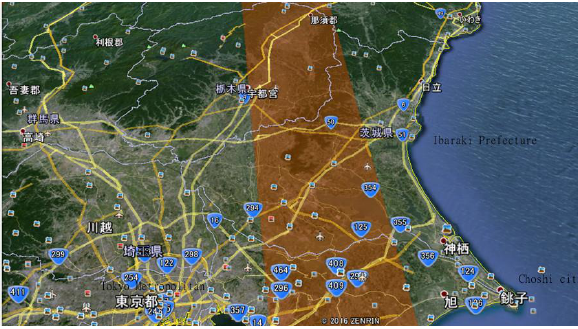
Figure1. Study area near Tokyo and ALOS-2 observation strip of land (red- coloured-band-image, on the Google earth)